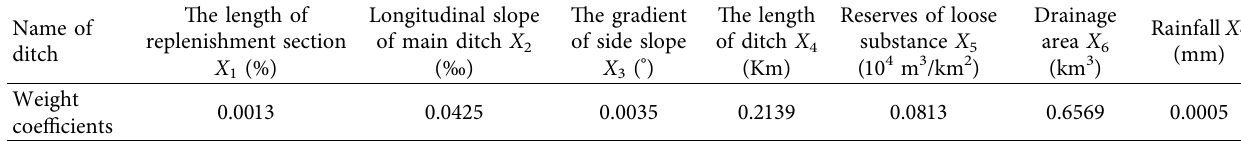
Table 5: The weight coefficient matrix.